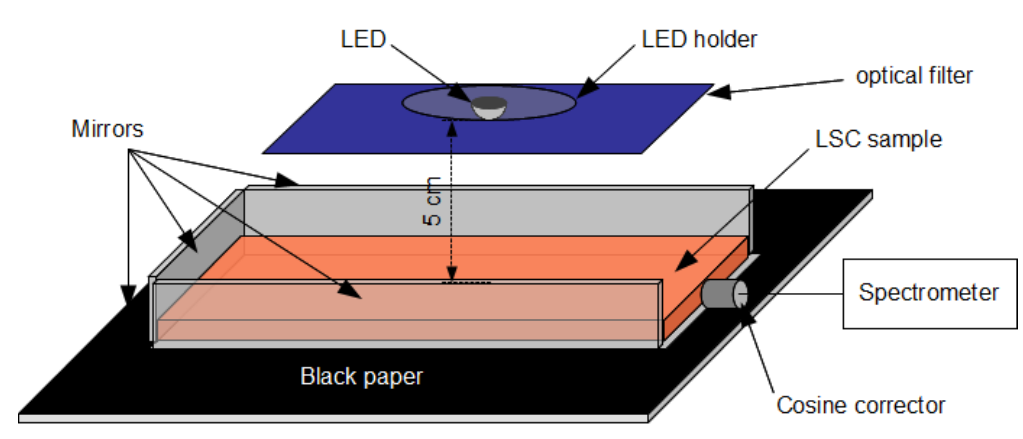
Figure 8. Experiment